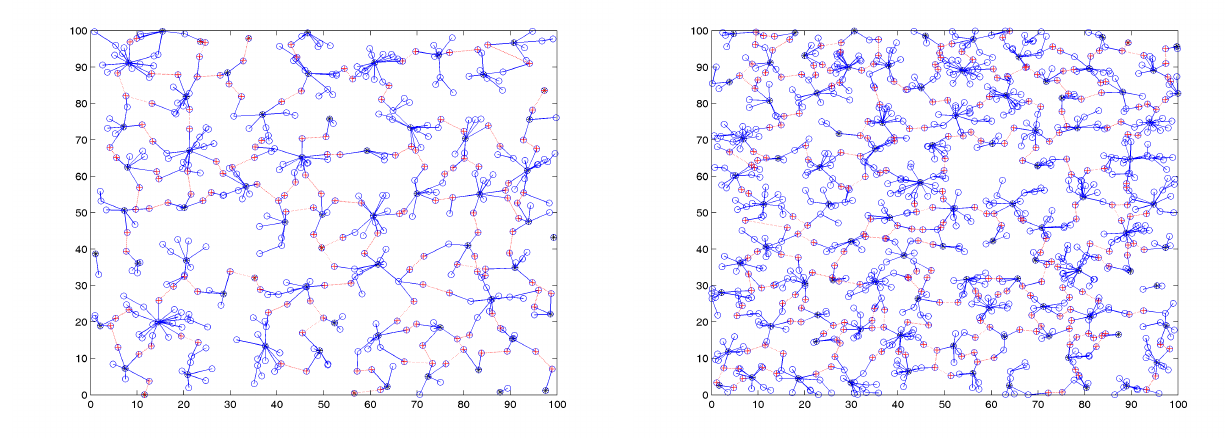
Figure 12. A random network with 500 sensors, R = 6.33, and (cid:96) = 100 (left); a random network with 1000 sensors, R = 4.48, and (cid:96) = 100